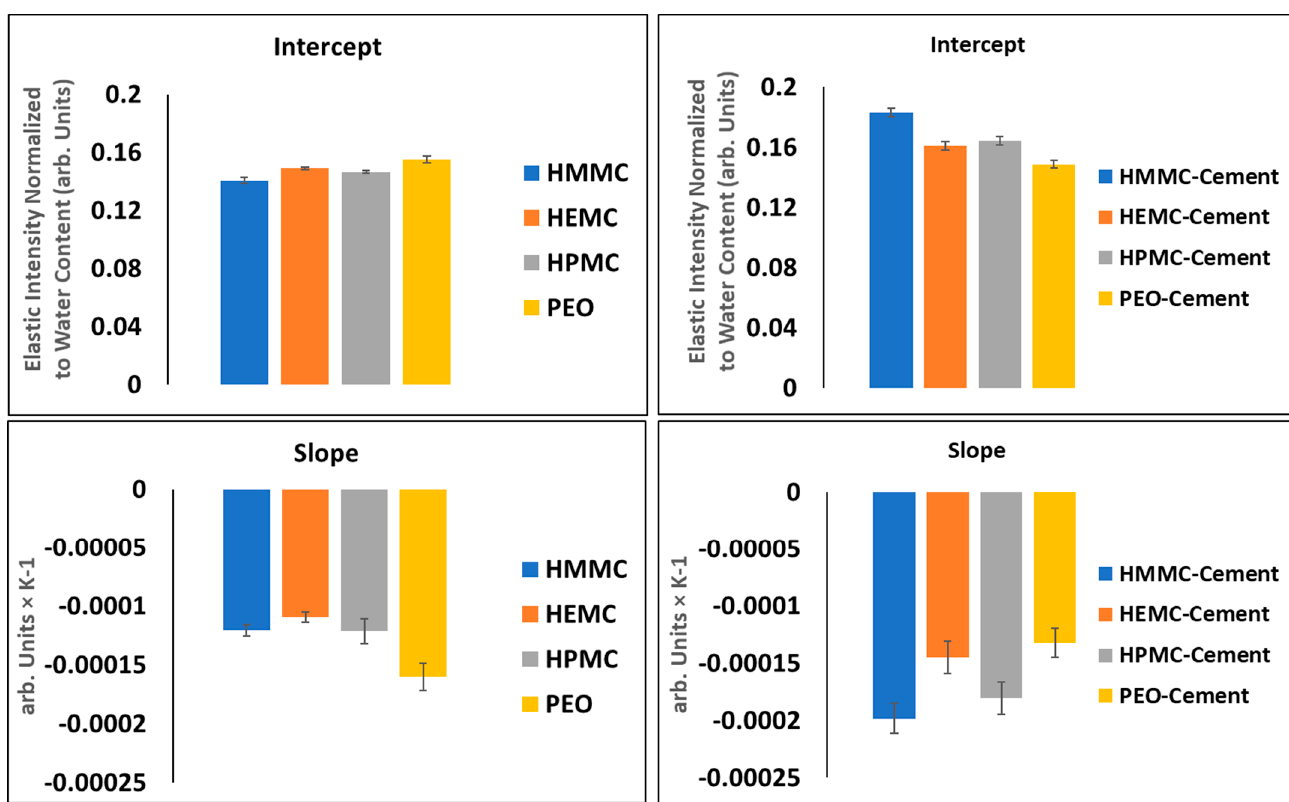
Figure 9. Regression analysis of linear region of cooling section for gel ( left-side ) and gel-cement pastes ( right-side ).